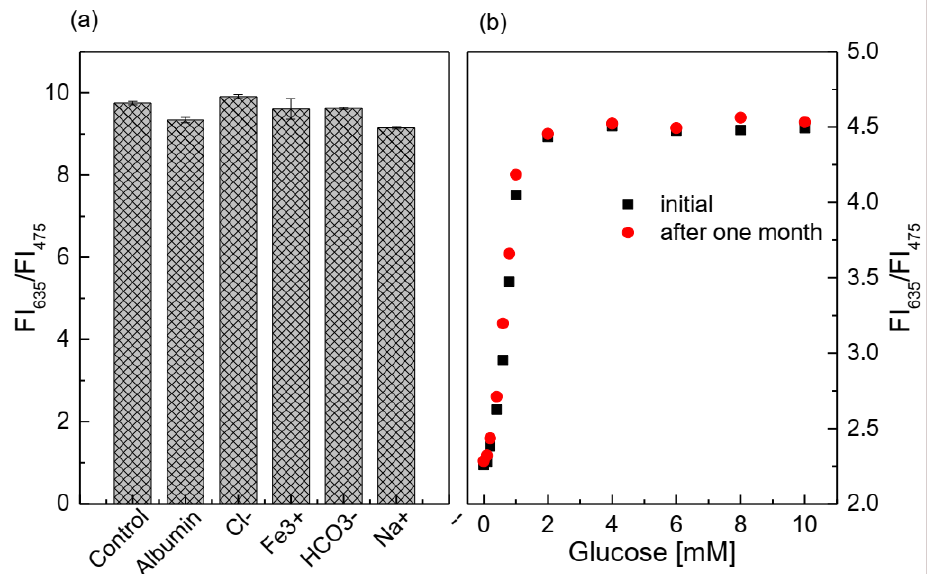
Figure 7. ( a ) Response of the glucose-sensing membrane at 1 mM glucose (control sample), with and without the addition of 145 mM Na + , 106 mM Cl − , 30 mM HCO 3 − , 1.625 mg/L Fe 3+ , and 5 g/dL BSA; ( b ) lifetime of the glucose-sensing membrane at different glucose